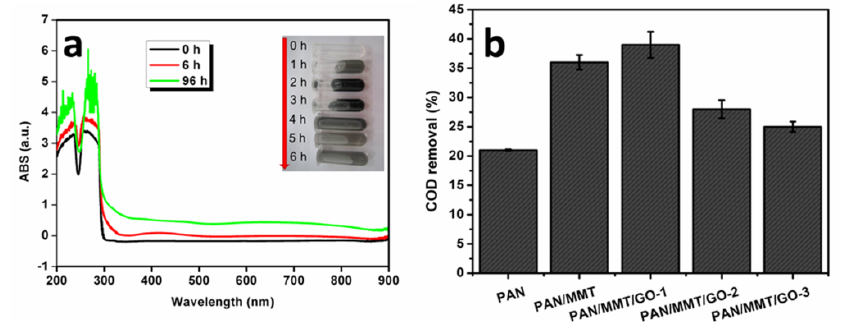
Figure 10. ( a ) UV-vis spectra of end products from catechol catalyzed by laccase immobilized on PAN/MMT, the inset shows digital photographs of the solutions collected at different time intervals; ( b ) Catechol COD removal by the immobilized